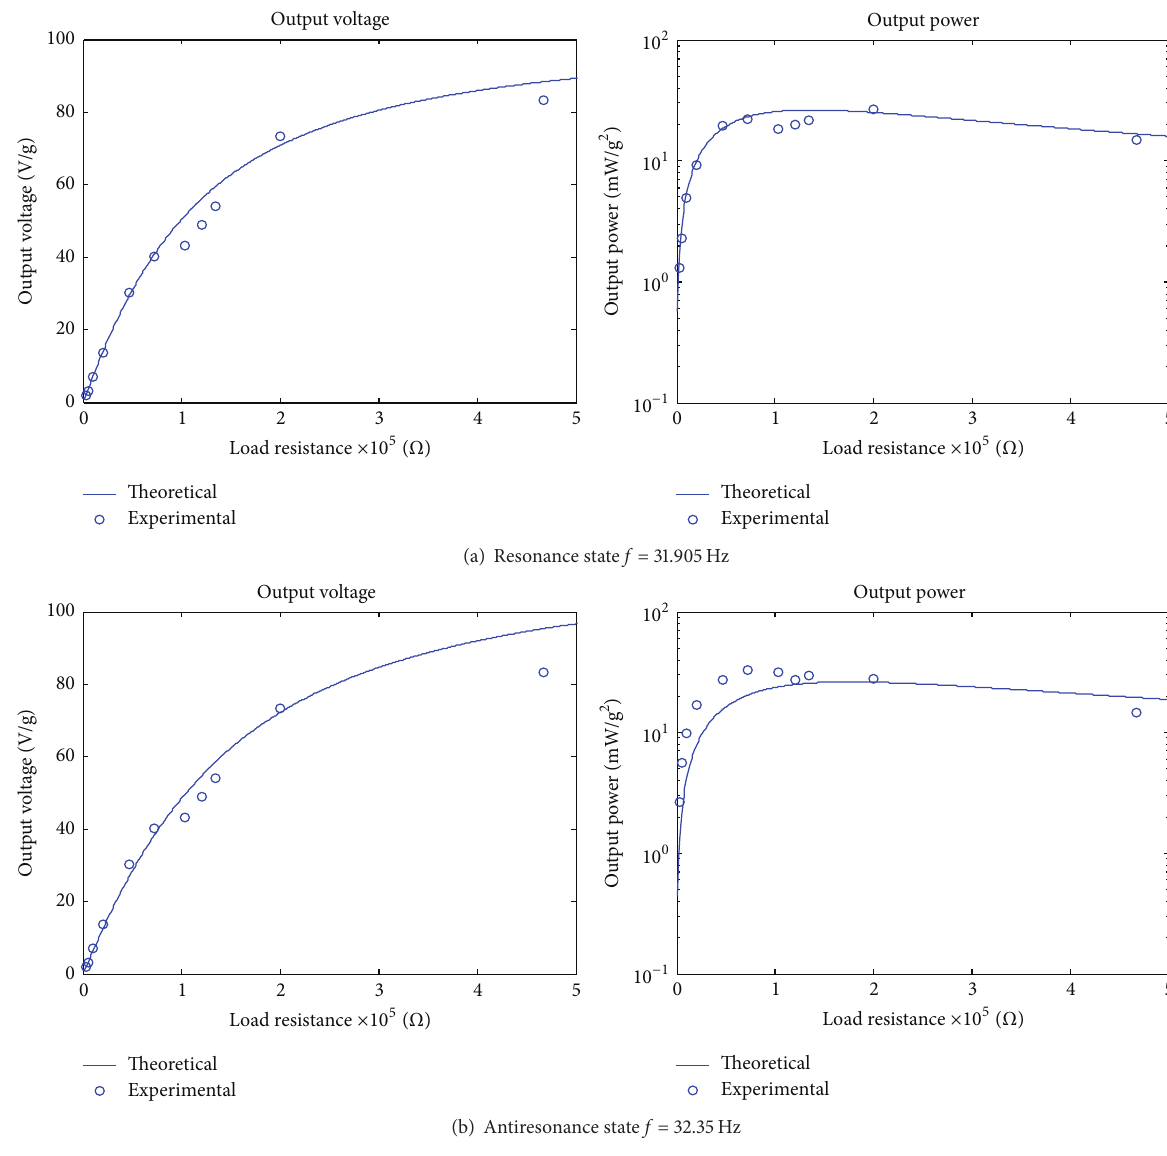
Figure 15: Output voltage and power of CPEH at resonance and antiresonance with the varying